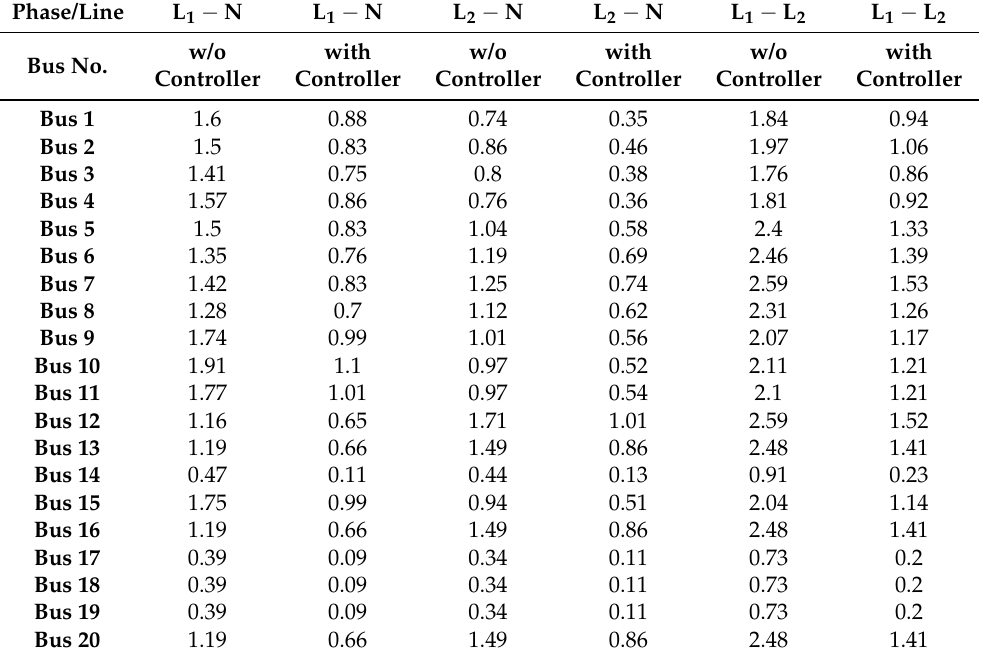
Table 5. Root mean square deviation in voltages in scenario 2 with and without the proposed